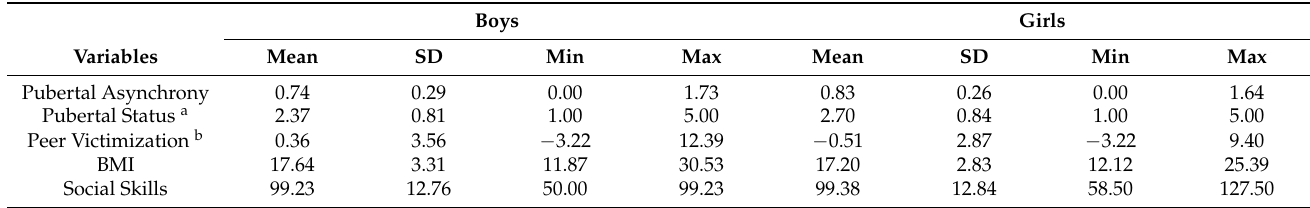
Table 4. Means and Standard Deviations of Study